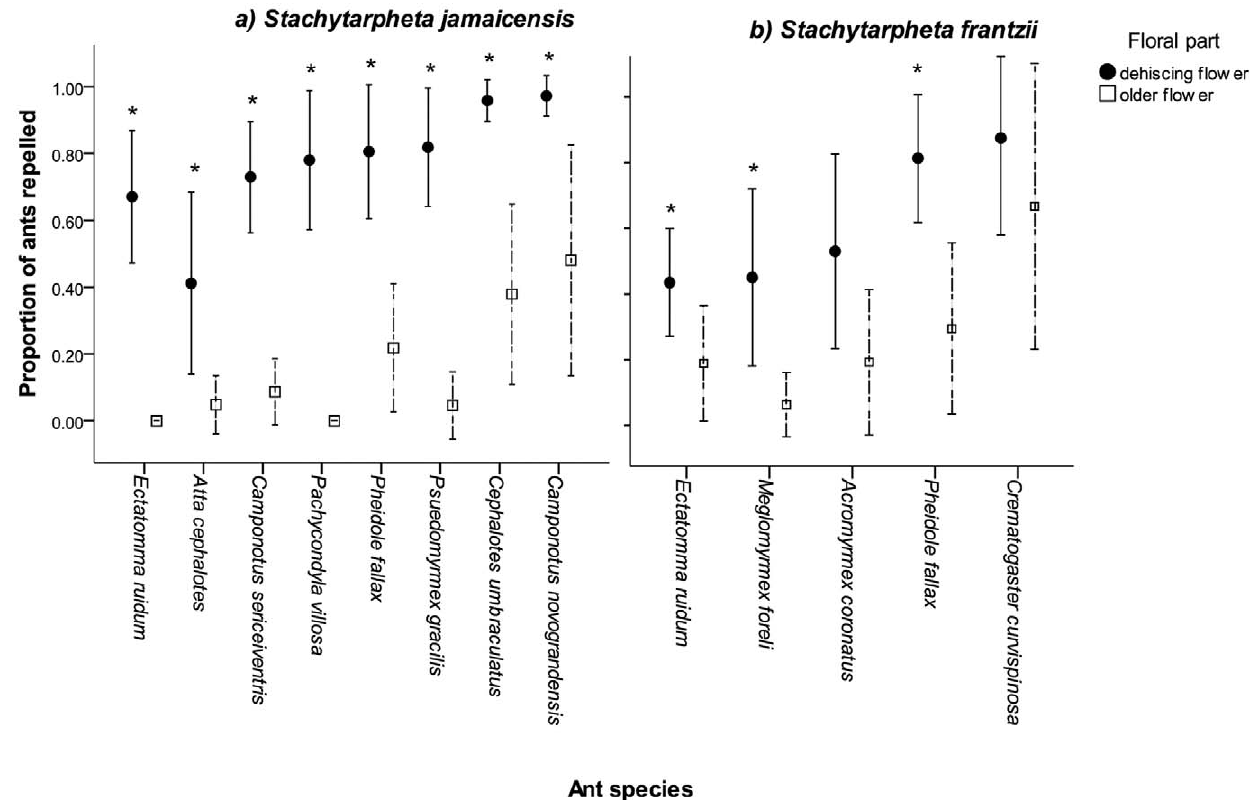
Figure 5. Floral ant-repellence in two species of Stachytarpheta tested against different ant species. (a) Stachytarpheta jamaicensis and (b) S. frantzii. * indicates significant difference between freshly dehisced flowers and old pollen-depleted flowers. Error bars indicate 95% confidence intervals.